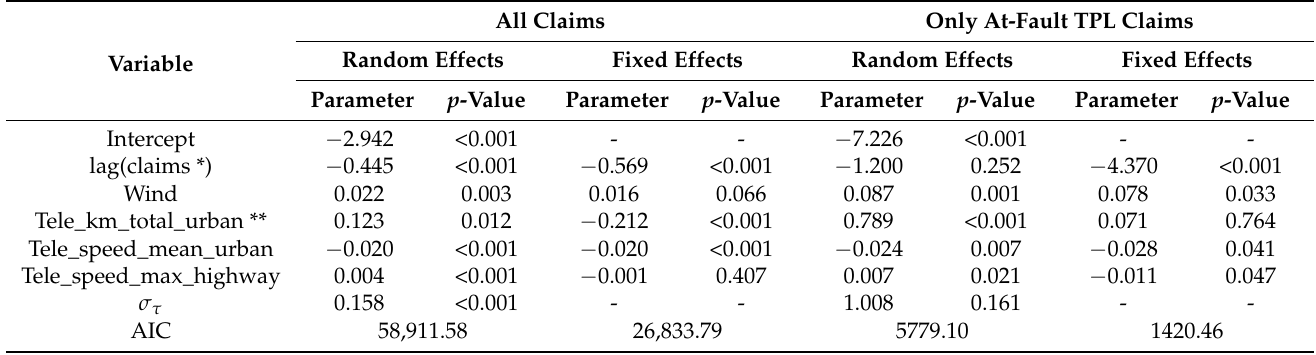
Table 3. Cross-table with the parameter estimates of random effects and fixed-effects Poisson panel data models, with p -values, for the total number of claims (left) and at-fault third-party liability (TPL) claims (right) per month and per insured based on the seven observed months in 2018 and